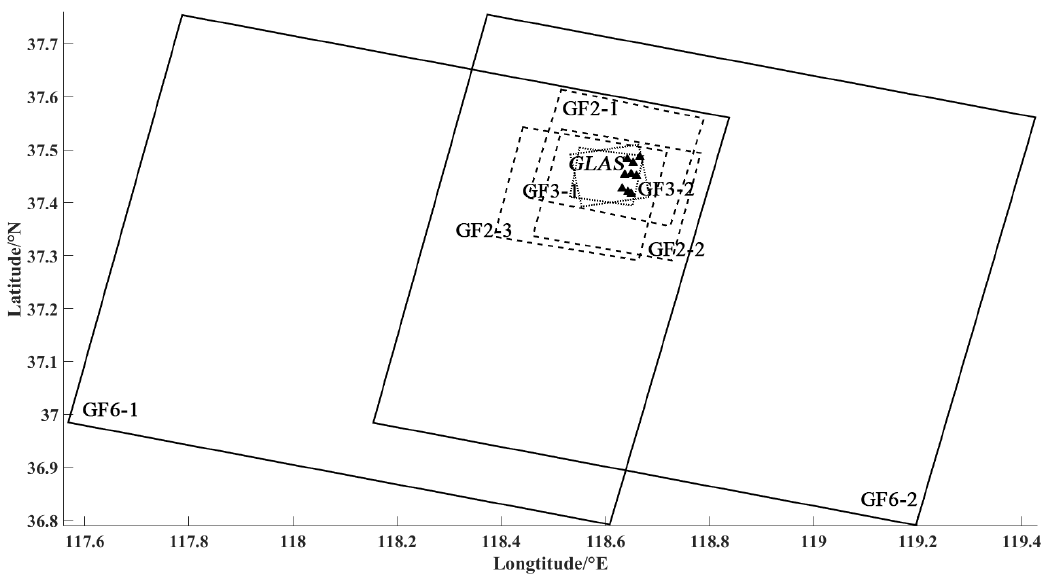
Figure 3. An illustration of the coverage area of the experimental data.